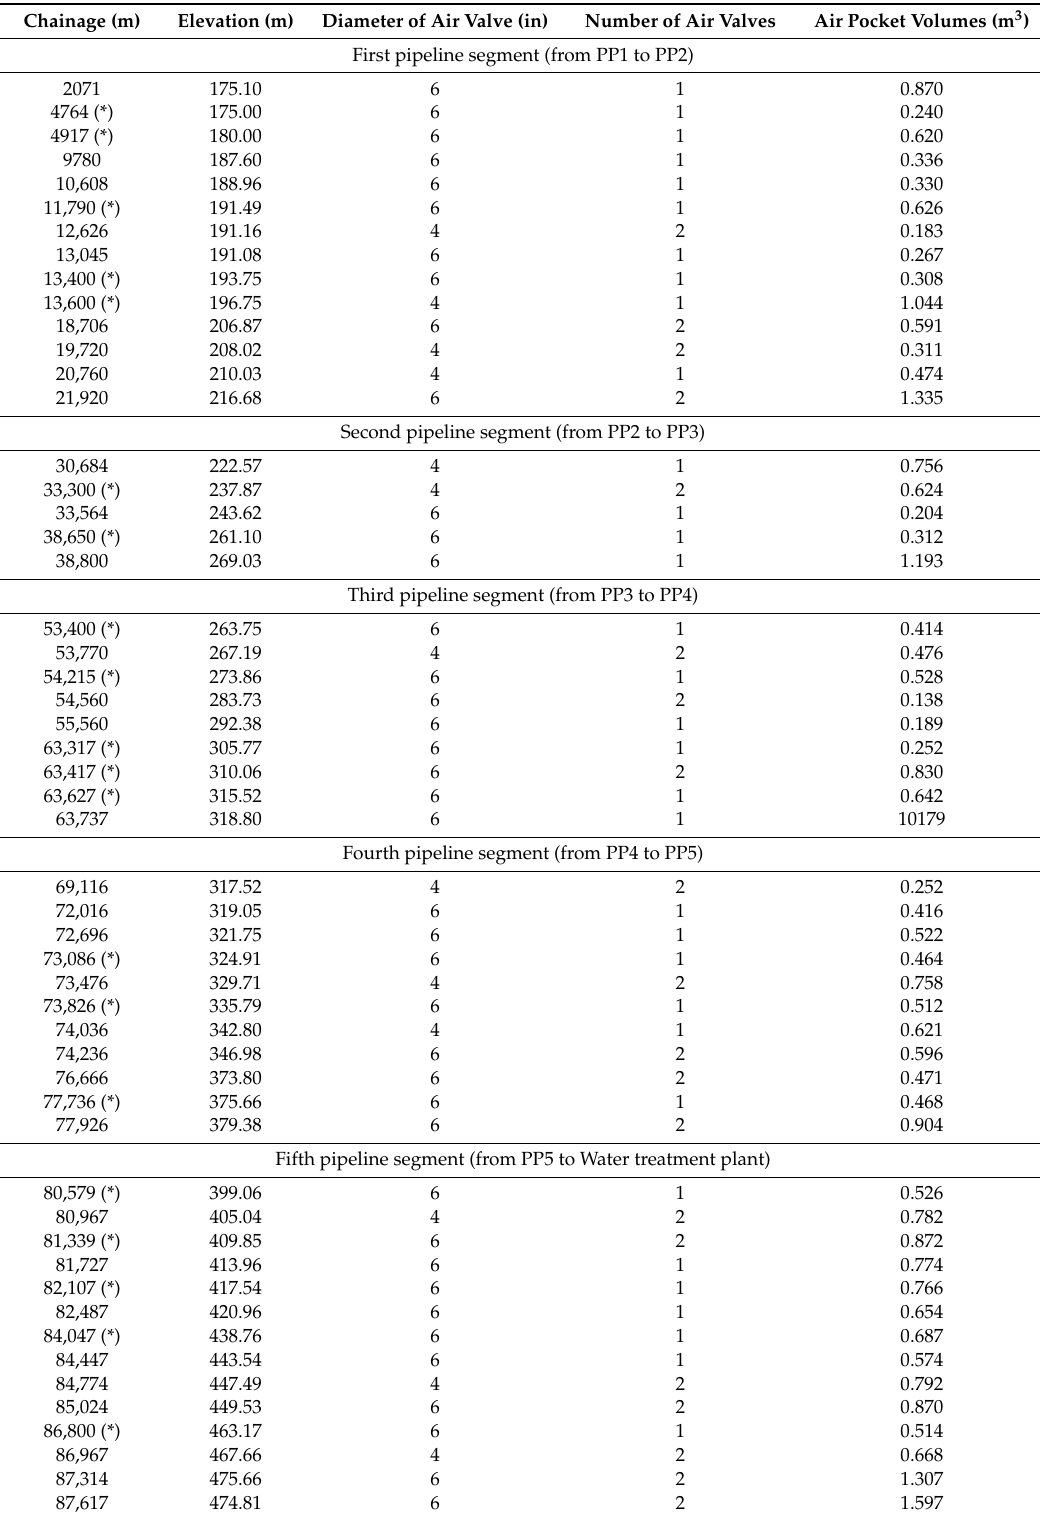
Table 4. Location and dimensions of air valves and air pocket volumes, (*) denotes the new air valves installed in the